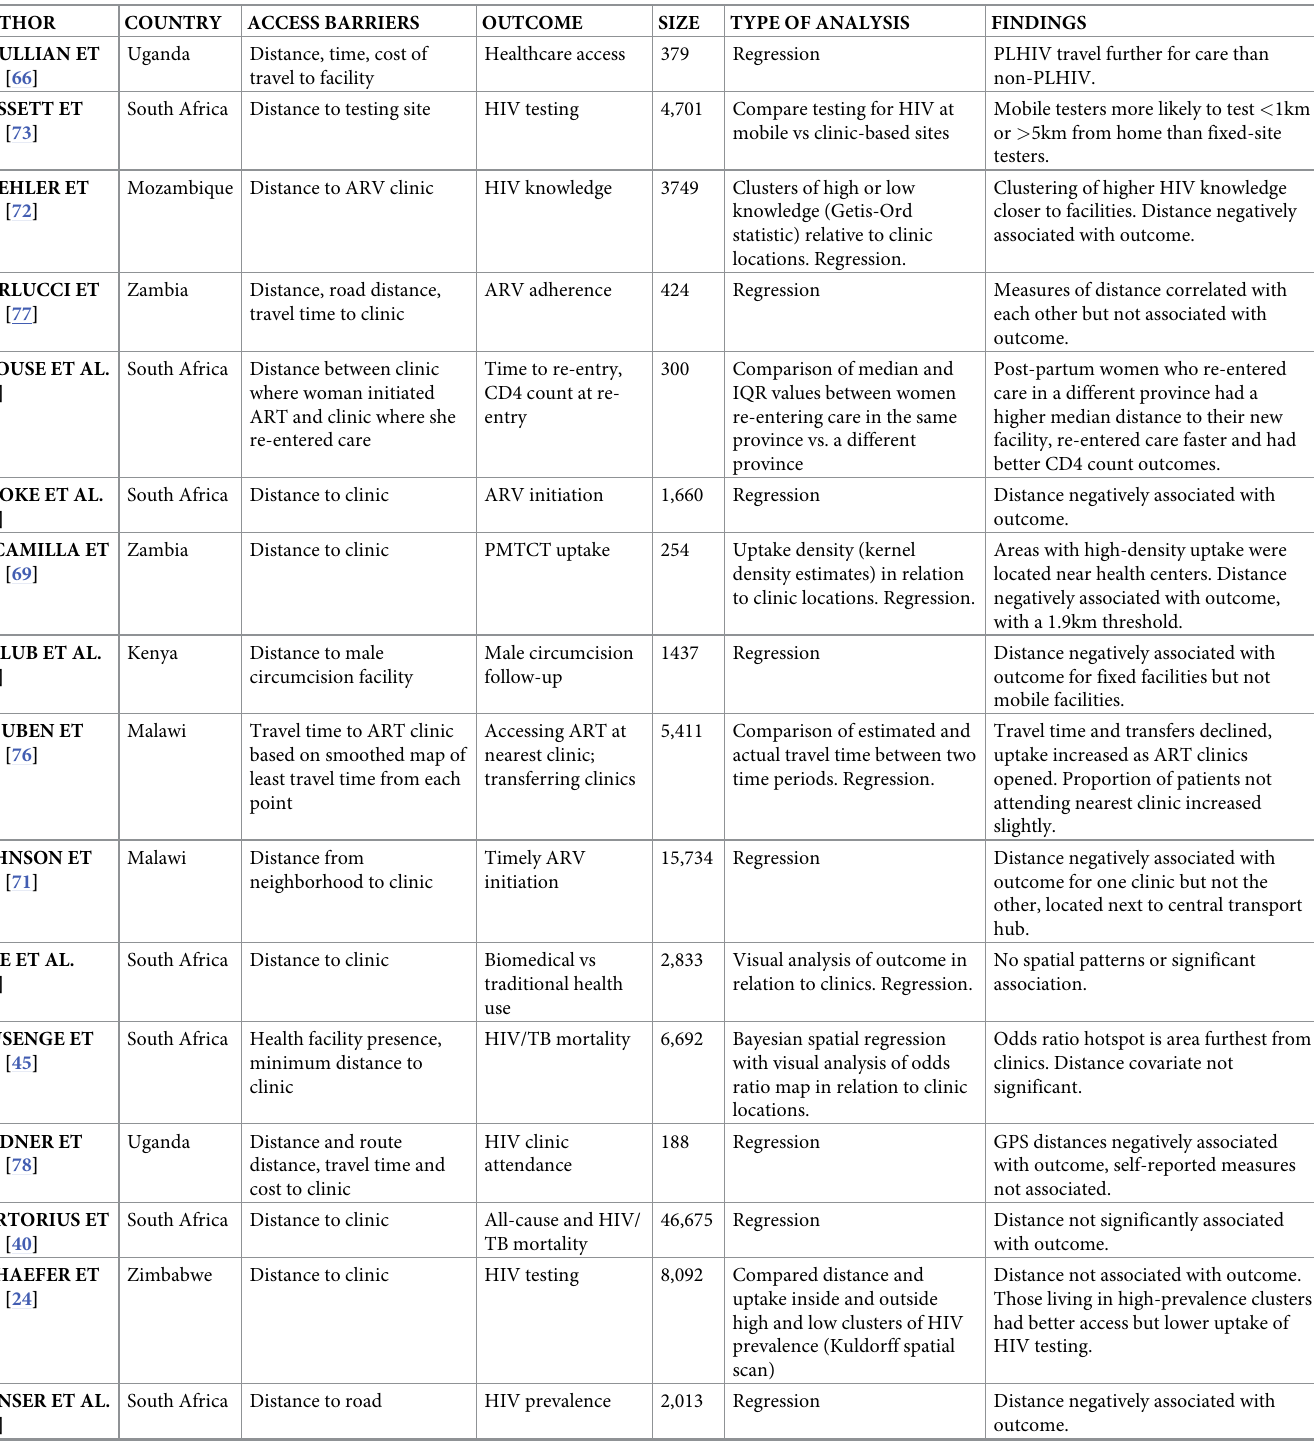
Table 5. Studies regarding the effect of distance to health